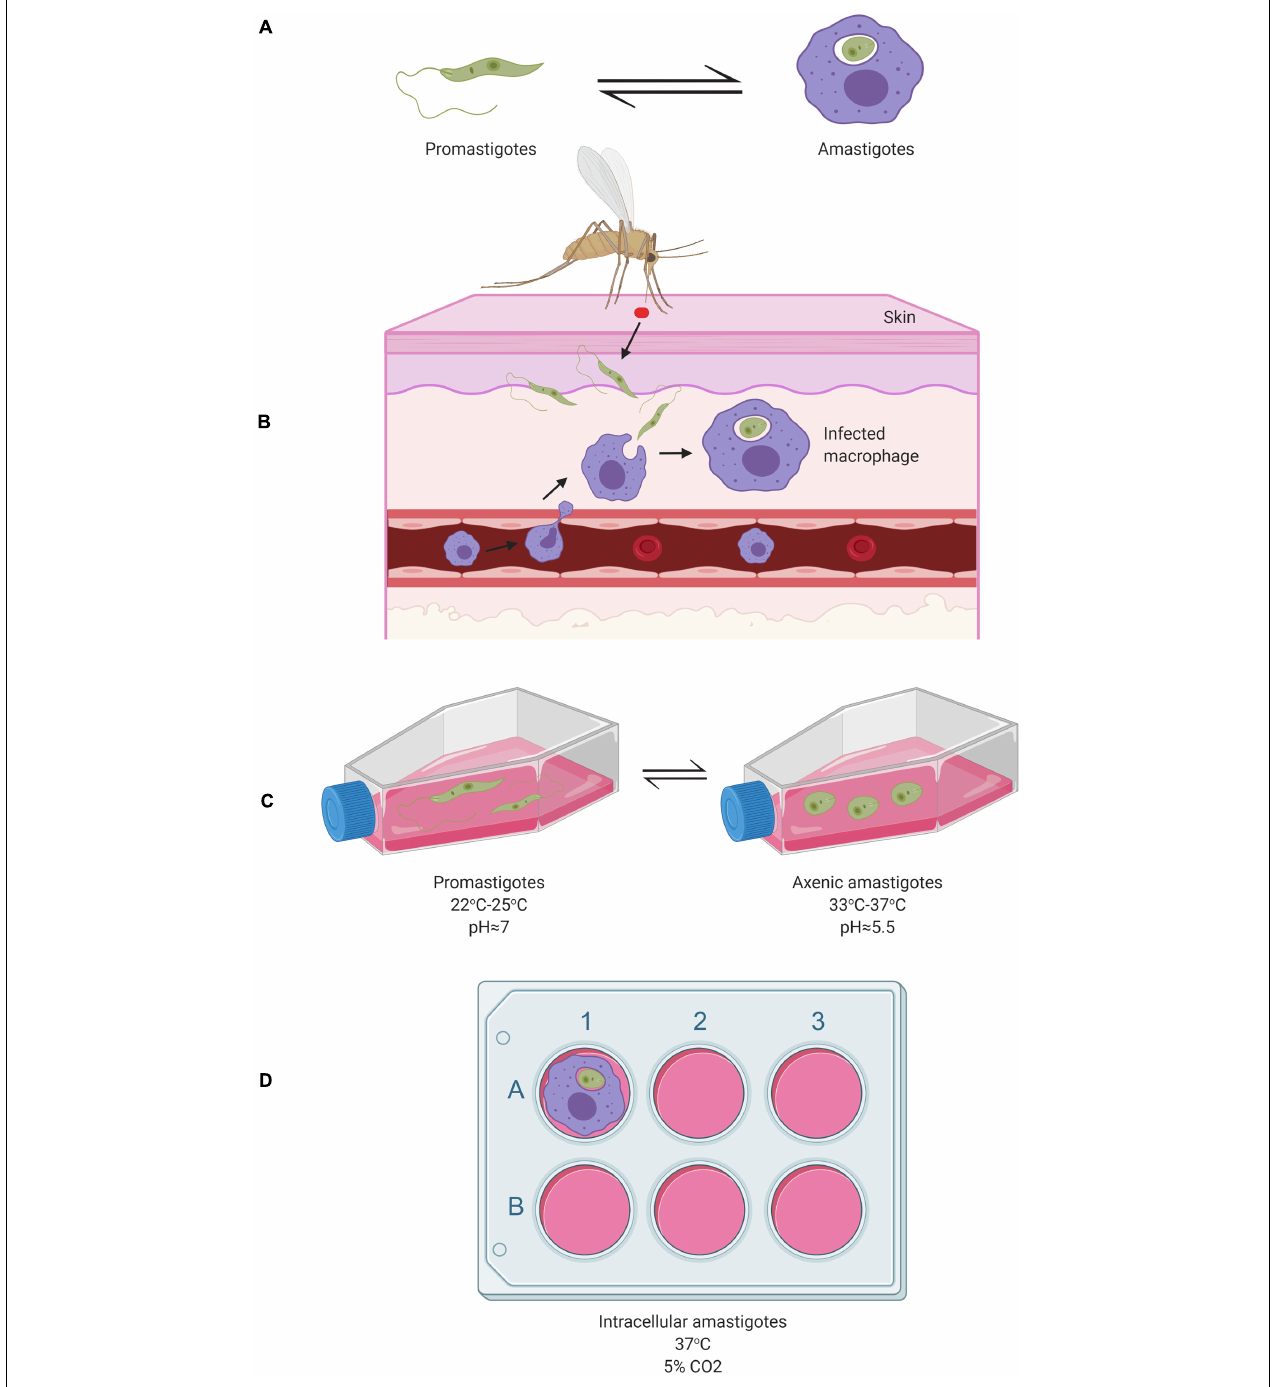
FIGURE 1 | Schematic representation of the two major Leishmania cellular forms during their digenic life cycle in vivo and their study in corresponding in vitro model systems. (A) The flagellated motile promastigotes form (left) in the gut of a sandfly and the round intracellular amastigotes form residing inside infected mammalian macrophages (right), represent the two major cellular forms of Leishmania species. (B) Under in vivo conditions, sandfly vectors inject Leishmania promastigotes into the host’s skin following a blood meal which are then taken up by macrophages where they differentiate into amastigotes; (C) Under in vitro conditions, axenic promastigotes can be maintained in cell culture flasks in a rich, 10%- Fetal Bovine Serum (FBS)-supplemented medium (e.g., RPMI 1640, Schneider, Grace, or M199) at 22–25 ◦ C (left). These can be differentiated in vitro into axenic amastigotes in a medium at an acidic pH ∼ 5.5 (Achieved through the addition of HCl) at 33–37 ◦ C (right) (Teixeira et al., 2002); (D) Macrophages (e.g., from human or mouse), can be seeded in 6-well cell plates in RPMI media supplemented with 10% FBS at 37 ◦ C to which the parasites are added resulting in macrophages infection within 4 to 24 h. More detailed aspects of the Leishmania life cycle are reviewed by Sunter and Gull (2017). Image created with